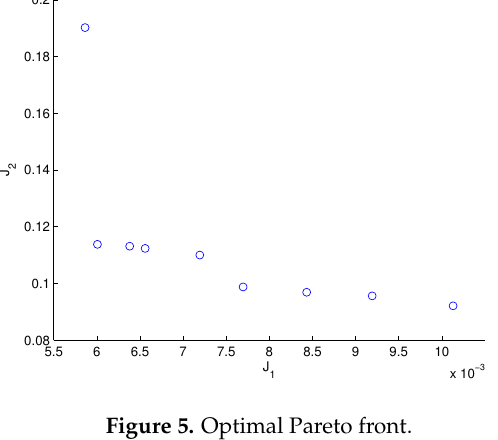
Figure 5. Optimal Pareto